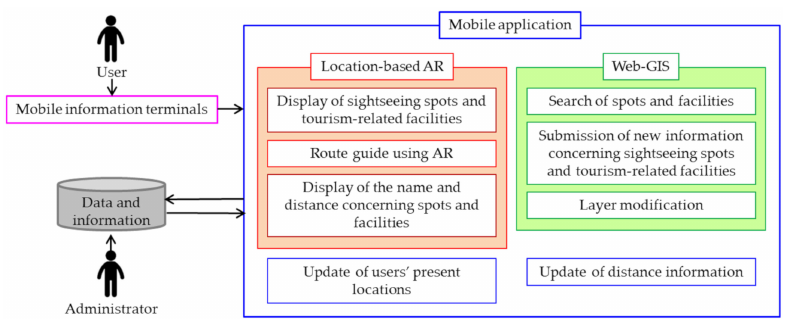
Figure 1. System